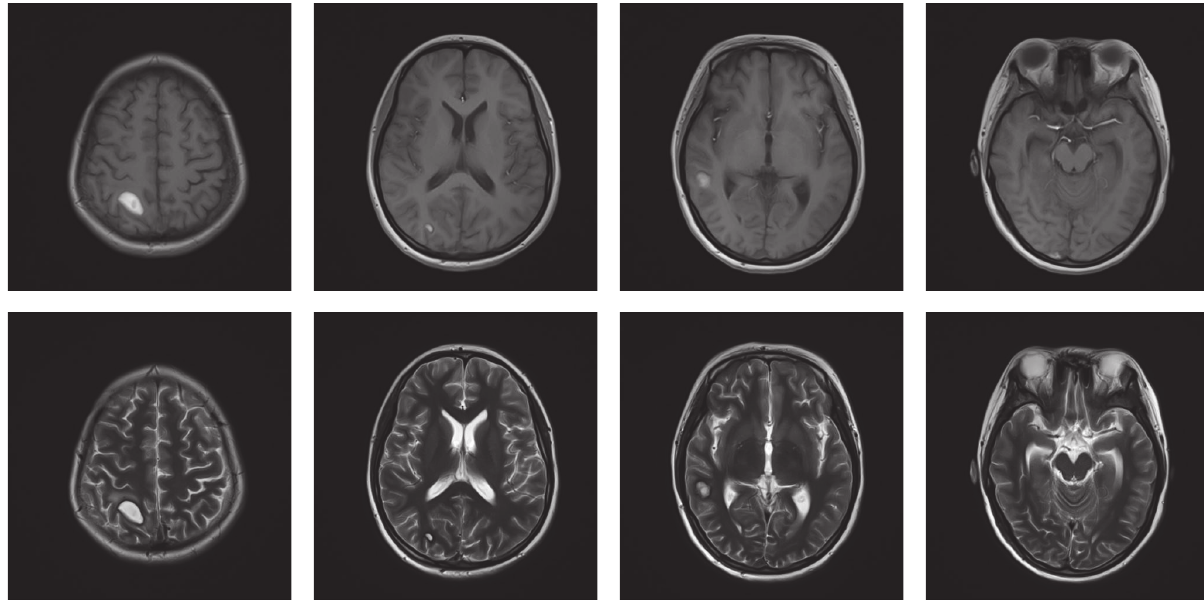
Figure 3: Brain MRI improved after one week of anticoagulation.